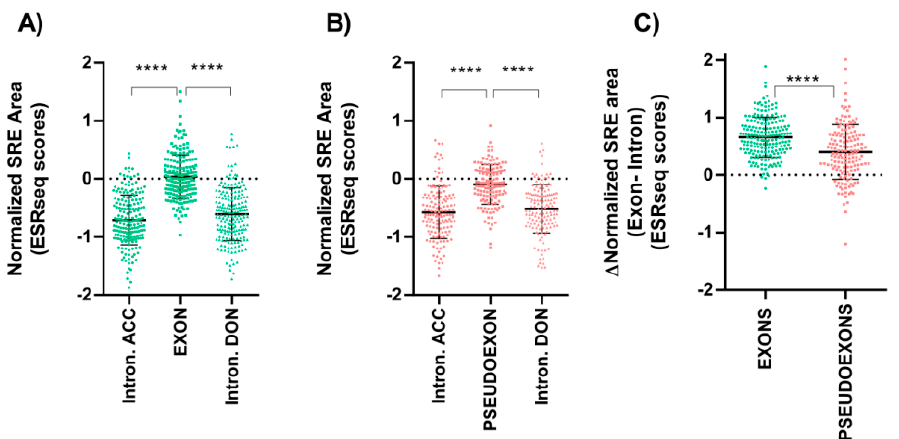
Figure 2. Definition of SREs abundance in different genomic regions, using the normalized SRE area calculated with ESRseq scores. ( A ) Normalized SRE area using ESRseq scores of exonic and adjacent 100 intronic nucleotides located upstream and downstream of canonical exons of HBOC and Lynch genes. Significant differences were identified between exons and intronic regions (Pair-wise significance levels calculated by Tukey test, **** p -value < 0.0001). ( B ) Normalized SRE Area using ESRseq scores of pseudoexons and adjacent 100 intronic nucleotides located upstream and downstream of pseudoexons listed in the literature dataset. Significant differences were identified between pseudoexons and intronic regions (Pair-wise significance levels calculated by Tukey test, **** p -value < 0.0001). ( C ) Comparison of the exon-intron difference of normalized SRE areas between canonical exons and pseudoexons. First, the mean of normalized SRE area of adjacent donor and acceptor site intronic regions was calculated. Then, this mean was subtracted from the exon and pseudoexon normalized SRE area value. The difference between exonic and intronic regions in canonical exons was higher than in the case of pseudoexons, suggesting that they are more defined by a SRE balance. ( t -test, **** p -value < 0.0001). Mean ± standard deviation is represented in